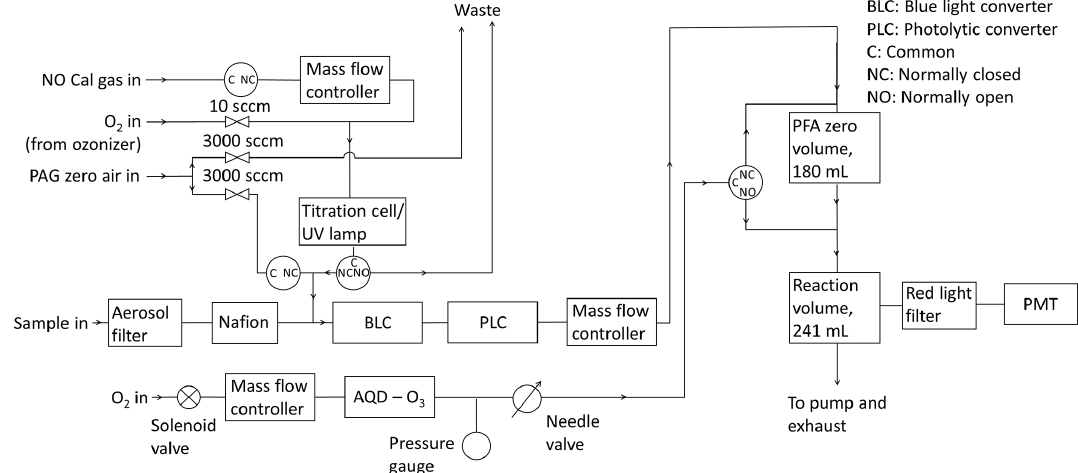
Figure 2. Flow diagram of the NO x instrument at the